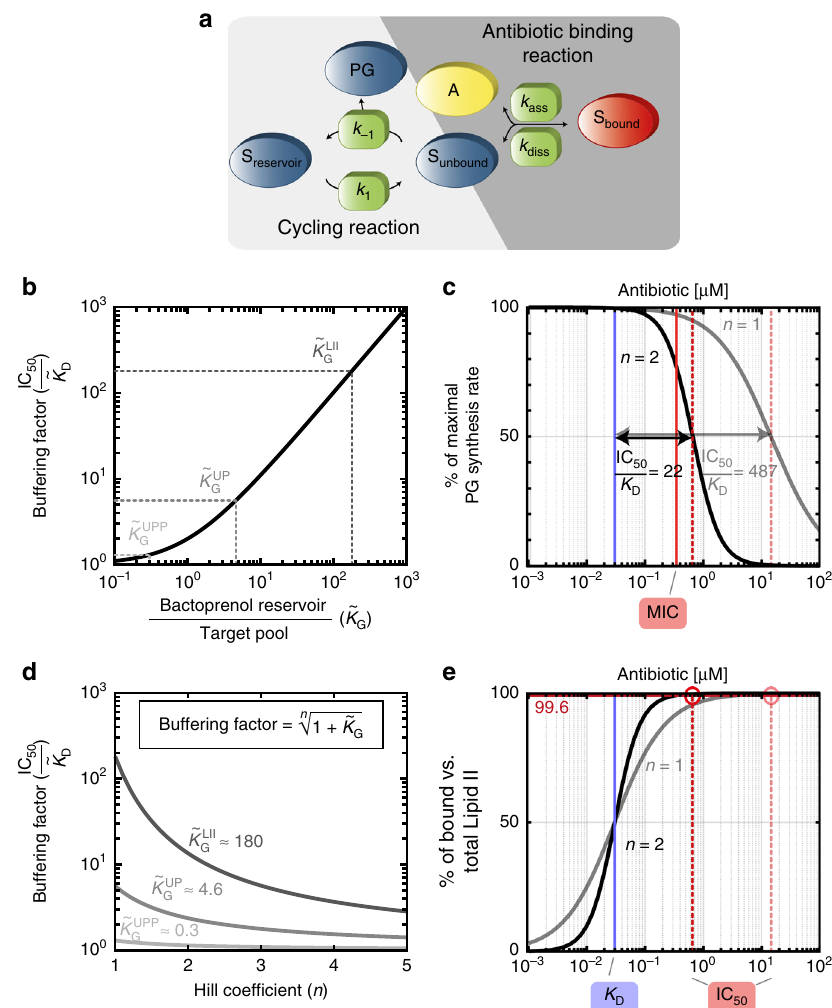
Fig. 4 A reduced model for the lipid II cycle rationalises the in vivo ef fi cacy gap and elucidates the boost of antibiotic potency by cooperative drug-target interactions. a The reduced model for the lipid II cycle considers antibiotic ( A ) binding to its lipid carrier target ( S unbound ) via fi rst order reactions with association- and dissociation rates k ass and k diss , respectively, leading to the antibiotic-bound form of the target ( S bound ). The model summarises all non- target lipid II cycle intermediates as a bactoprenol reservoir ( S reservoir ), which can be converted into the unbound lipid target intermediate and vice versa via IC 50 fi rst order kinetics at rate constants k k ¼ 1 þ ~ K , which is the major determinant of the in vivo ef fi cacy ~ K 1 and -1 , respectively. b The buffering factor G D ¼ S reservoir gap, increases for increasing bactoprenol reservoir size relative to the unbound target pool in the absence of the antibiotic ( S target ) according to ~ K . (cid:1) S G target Buffering factors are indicated for antibiotics binding to external lipid II ~ K LII G interaction on the IC 50 value predicted for lipid II-binding antibiotics. Assuming identical in vitro K D values (corresponding to the in vitro value of vancomycin; blue line) the model predicts that for an antibiotic variant binding in a cooperative manner (Hill coef fi cient n = 2; black and red dashed lines), the IC 50 is approximately 22 times lower than for a non-cooperative antibiotic binding ( n = 1; grey and pale red lines). The experimentally measured MIC for vancomycin ( red solid line 9 ), is close to the predicted IC 50 for the cooperative variant. d Scaling of the in vivo ef fi cacy gap with the Hill coef fi cient n within the reduced model (see Supplementary Fig. 2 for further details). e For the simulated vancomycin variants (binding to lipid II), the reduction of the PG synthesis rate to 50% requires that the equilibrium is strongly shifted towards the bound form of lipid II (99.6% bound vs. total lipid II). As increasing Hill coef fi cients n generally lead to steeper binding curves, the required level of target binding is achieved at a 22-fold lower antibiotic concentration by cooperative antibiotic binding (black) compared to the non-cooperative variant (grey)